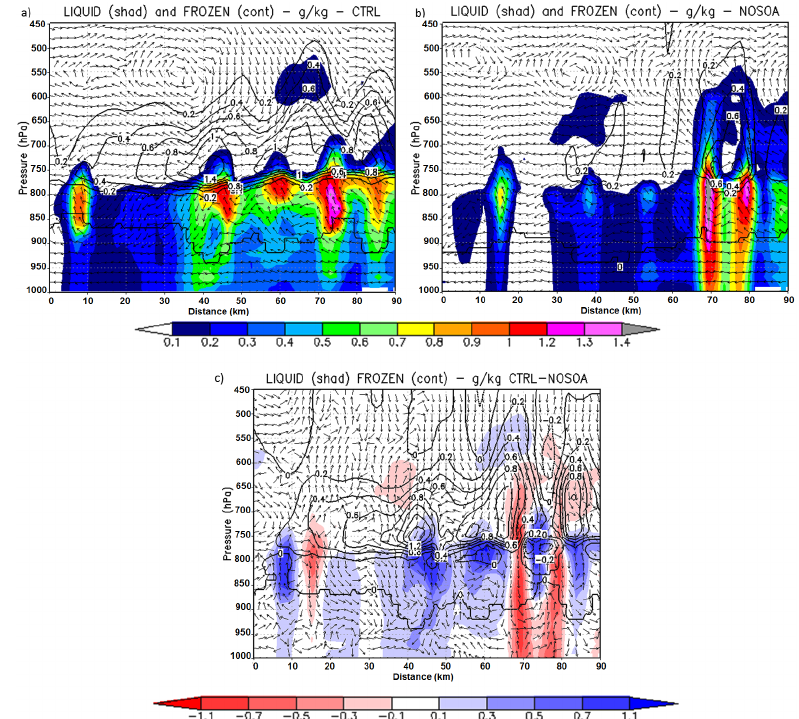
Figure 17. As in Fig. 16, but for water (colour), and frozen (black contours)